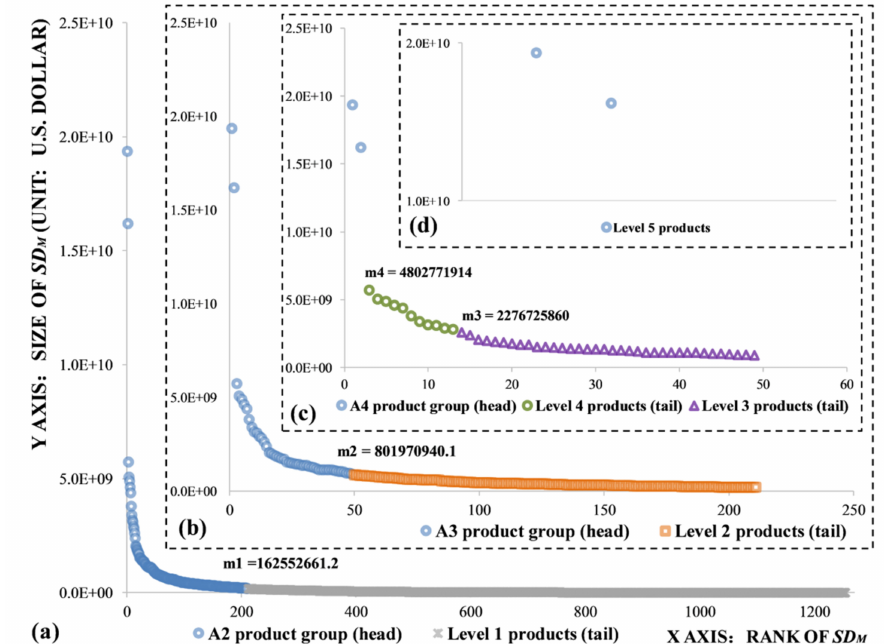
Figure 3. Classification process of the rank–size distribution of SD M based on the head / tail breaks. ( a ) Extract Level 1 products–m1 is the arithmetic mean of all SD M values; values above m1 were extracted as an A2 product group (head), and the rest as Level 1 products (tail). ( b ) Extract Level 2 products–m2 is the arithmetic mean of A2 values0; values above m2 were extracted as an A3 product group (head), and the rest as Level 2 products (tail). ( c ) Extract Level 3, 4 products in sequence. ( d ) Define Level 5